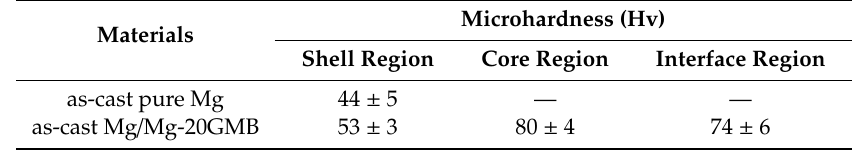
Table 3. Microhardness values for as-cast Mg / Mg-20GMB hybrid composite.